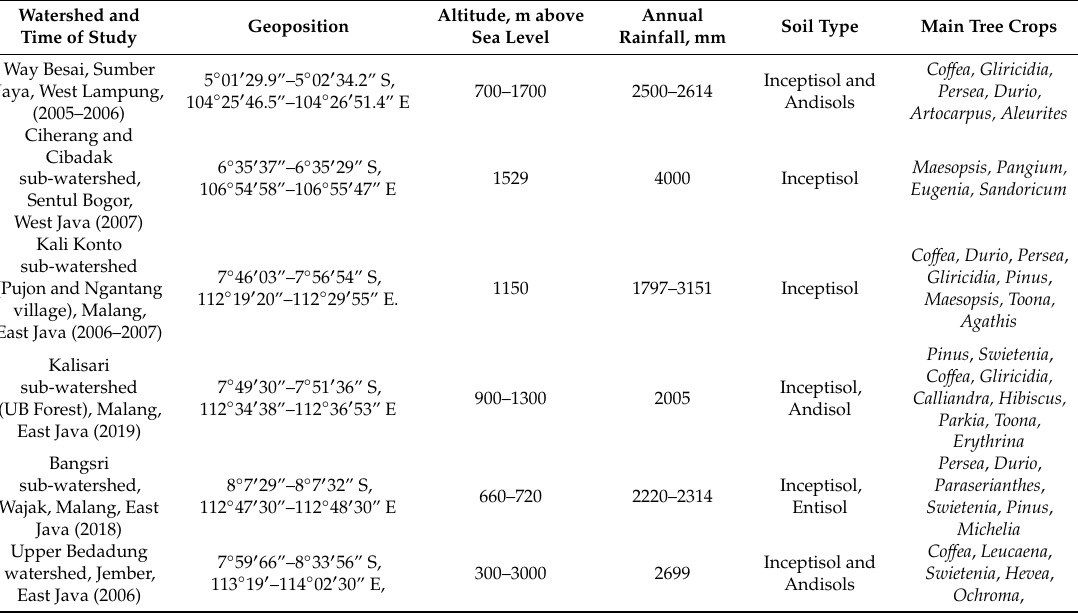
Figure 1. Location of six study sites in East Java, West Java, and Sumatra. Table 1. Geoposition and characteristics of five study sites.